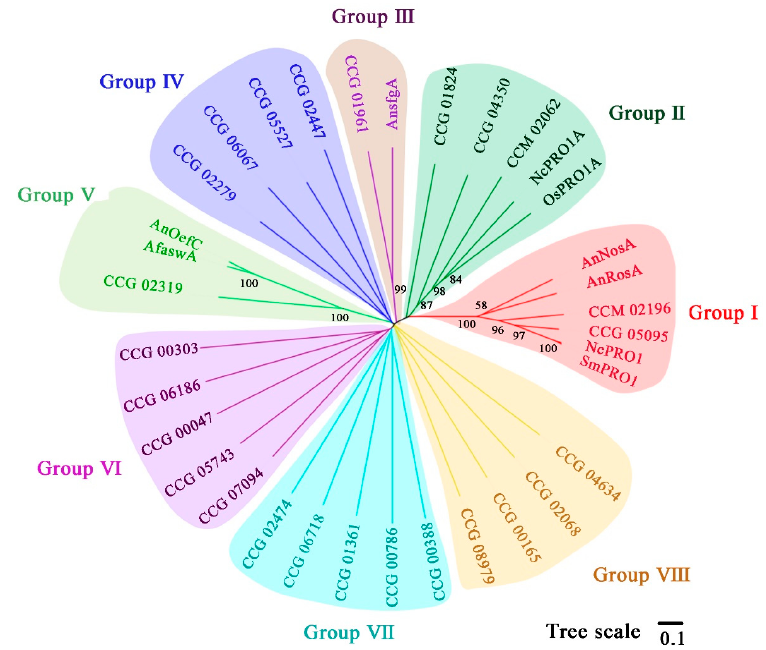
Figure 4. Phylogenetic relationship of 34 DUF3468 domain contained C6 zinc proteins in T. guangdongense. Amino acid sequences were aligned using ClustalW, and phylogenetic tree were generated by the neighbor-joining (NJ) method using MEGA 5.0. Numbers at the branch point of the node represent the value resulting from 1000 replications. All positions with less than 50% site coverage were